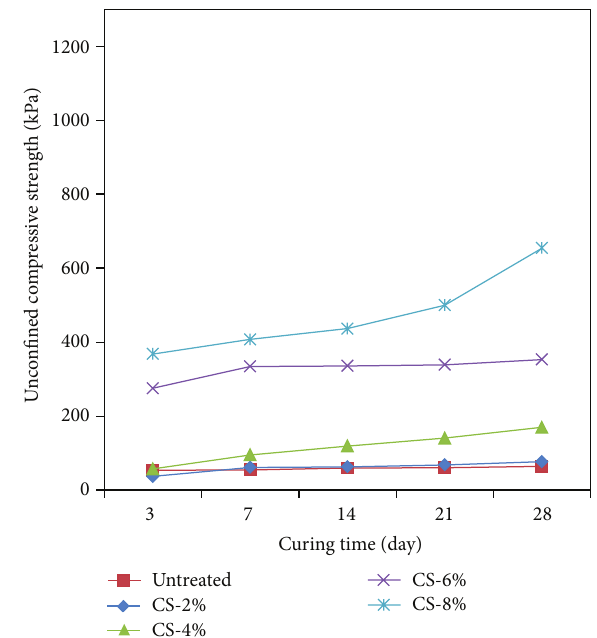
Figure 10: Curing period to compare the strength of calcium carbonate + cement